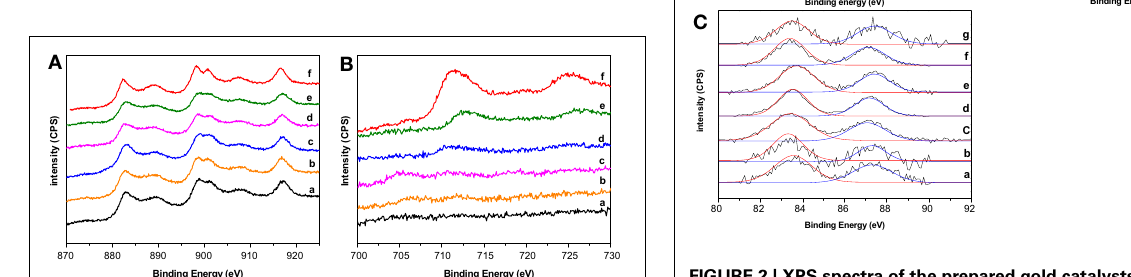
FIGURE 2 | XPS spectra of the prepared gold catalysts. (A) Ce3d region: (a) Au/Ce/Al, (b) Au/CeFe0.5/Al, (c) Au/CeFe1/Al, (d) Au/CeFe1.5/Al, (e) Au/CeFe2/Al, (f) Au/CeFe3/Al; (B) Fe2p región: (a) Au/CeFe0.5/Al, (b) Au/CeFe1/Al, (c) Au/CeFe1.5/Al, (d) Au/CeFe2/Al, (e) Au/CeFe3/Al, (f) Au/Fe/Al; (C) Au 4f region (a) Au/Ce/Al, (b) Au/CeFe0.5/Al, (c) Au/CeFe1/Al, (d) Au/CeFe1.5/Al, (e) Au/CeFe2/Al, (f) Au/CeFe3/Al, (g)